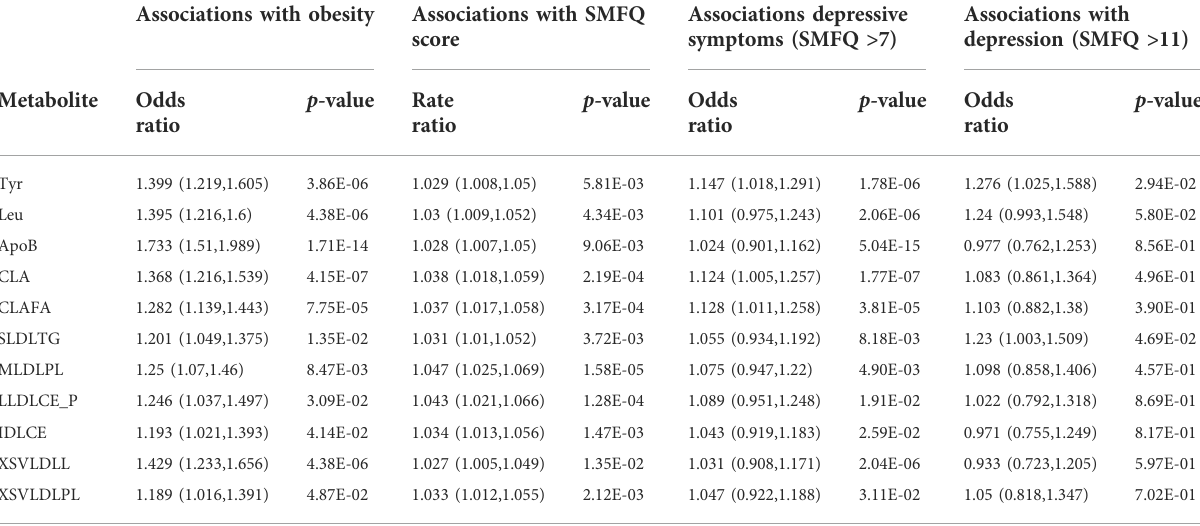
TABLE 2 Metabolites simultaneously associated with obesity at 7 years and with SMFQ score at 11, with consistent directions of